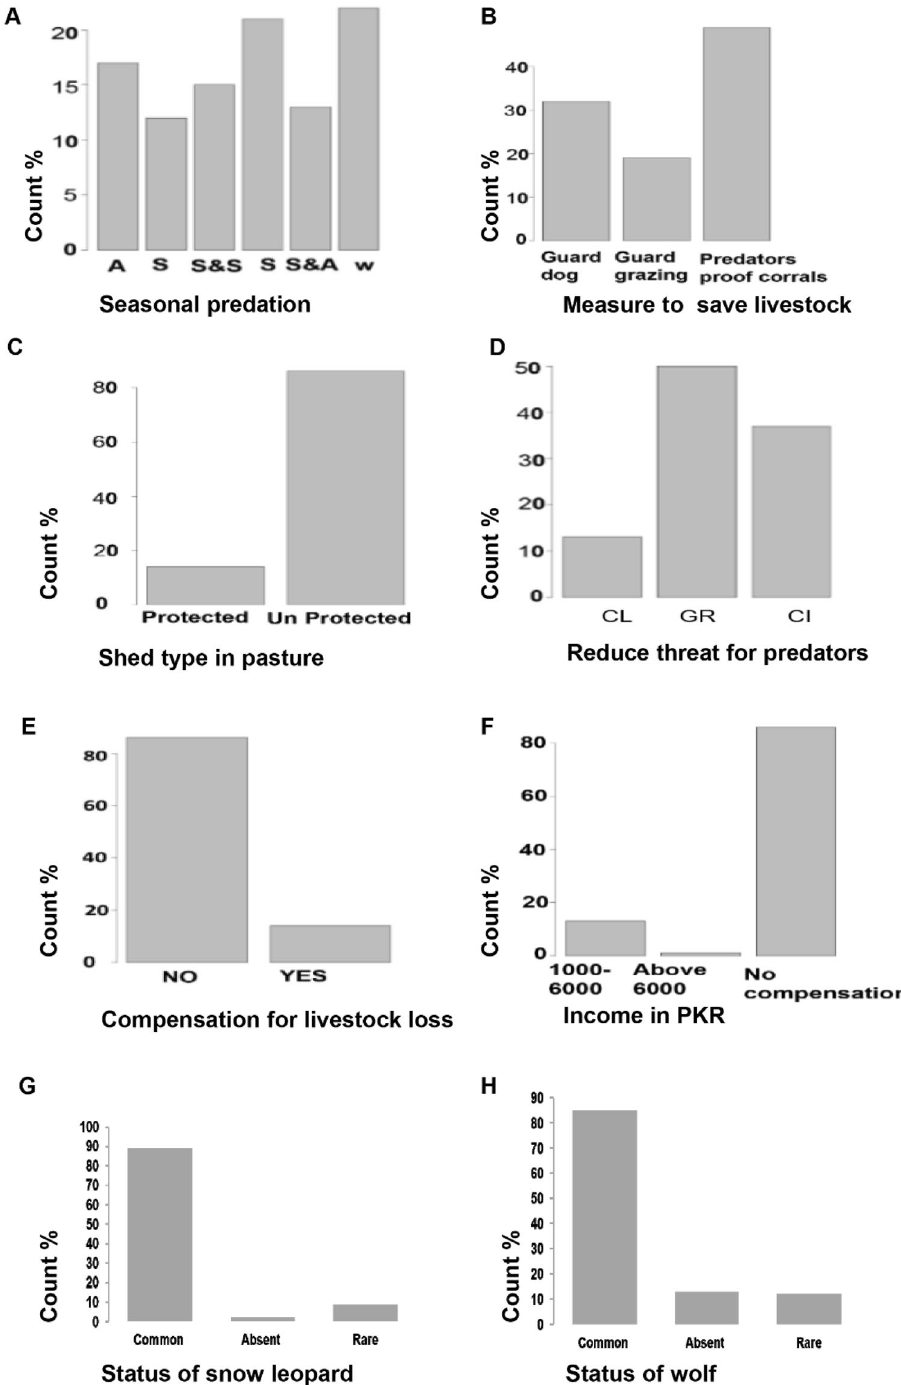
Figure 5. Conservation strategies towards the protection of predators in Misger Valley. Seasonal predation ( A ) is categorized as autumn (A), summer (S), spring and summer (S&S), spring (S), summer and autumn (S&A). Effects of protection measures for livestock and pastures are presented in B and C , respectively. Mitigation measures ( D ) included conservation laws (CL), Government rules (GR), community involvement (CI). Graphs E – H show compensation for losses, household income, population status of snow leopard and wolf,